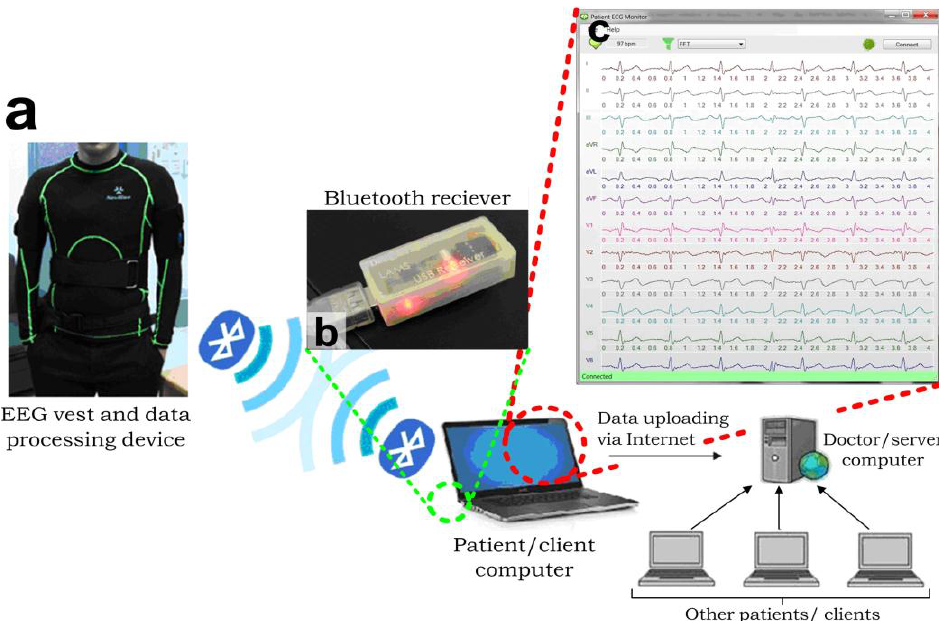
Figure 5. Architecture of the integrated ECG measurement system [36]. ( a ) EEG vest and